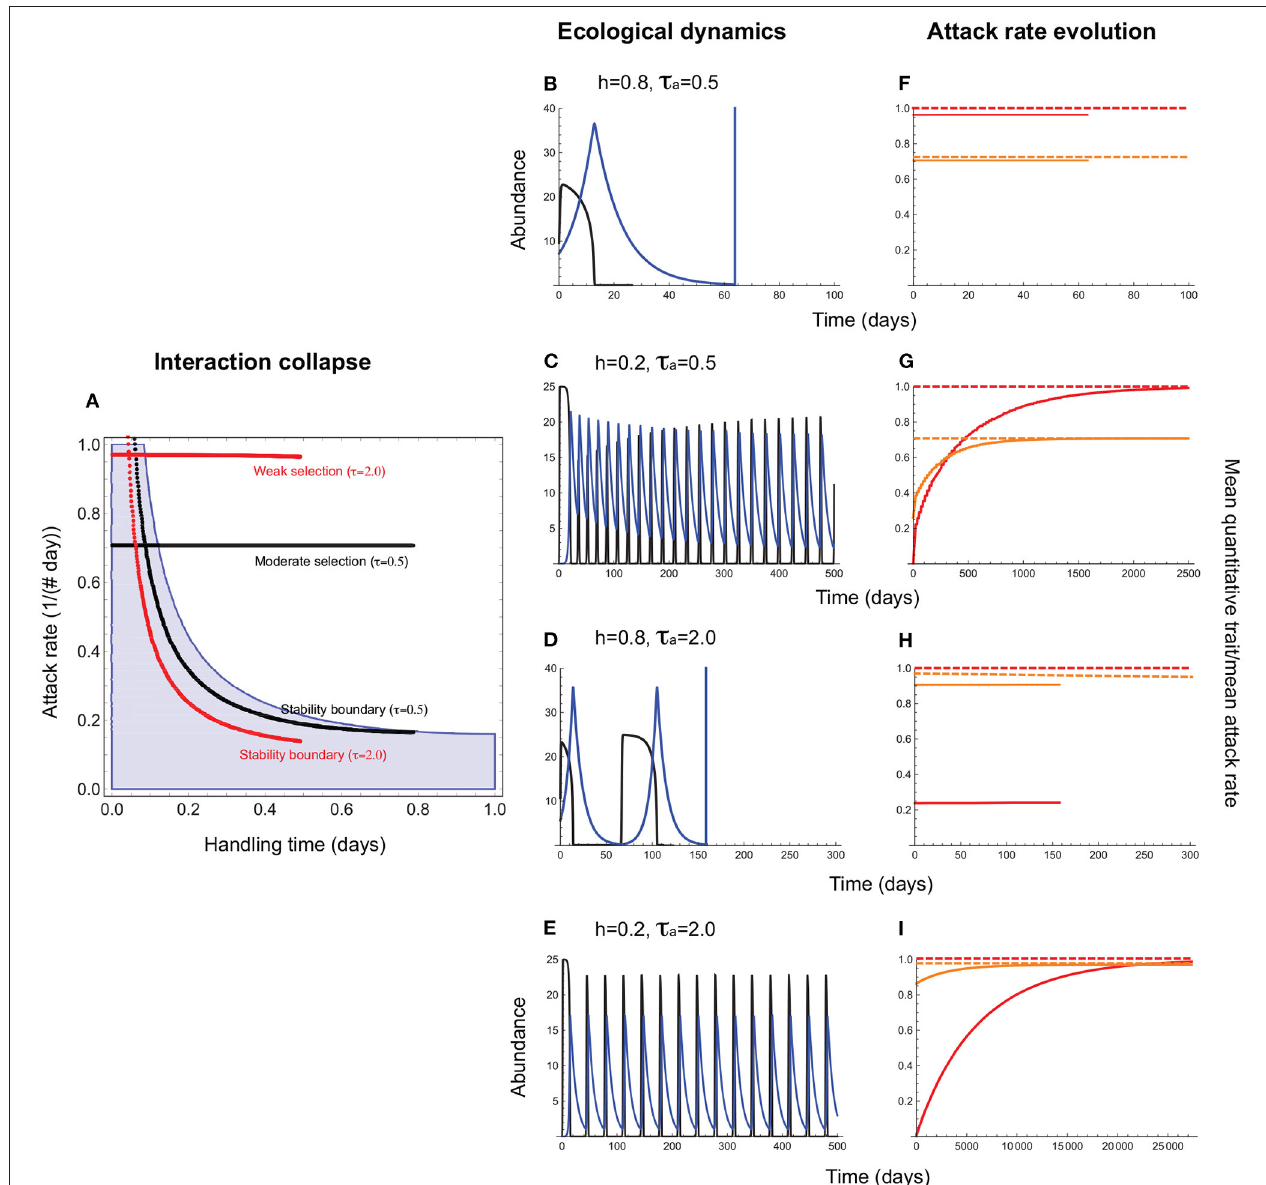
FIGURE 3 | Attack rate evolution (Equation 11) when the handling time acts as a constraint. (A) depicts the attack rate-handling combinations that evolve in the model for varying strengths of stabilizing selection ( τ a ). (B–I) depict four representative cases of eco-evolutionary dynamics. In (A) , the red and black horizontal lines depict the attack rate-handling combinations that evolve in the model for weak ( τ a 2.0) and moderate ( τ a 0.5) selection. Note that these lines terminate before the = = handling time reaches its maximum ( h 1.0) because when h is long, oscillations become sufficiently large to cause interaction collapse if negative feedback is too = weak to prevent divergent oscillations. The red and black curves represent the corresponding stability boundaries calculated using these evolved combinations. The blue shaded region depicts the attack rate-handling time combinations that yield a stable point equilibrium in the absence of evolution ( Appendix A ). (B–E) depict resource (black) and consumer (blue) abundances and (F–I) , the mean attack rate [ a ( x ), orange line] the corresponding quantitative trait mean ( x , red line), the ατ a a ( θ a ) expected optima for a ( x ) ( 0.8) leads to ; orange dashed line) and x ( θ a ; red dashed line). (B,F) illustrate the case when a long handling time ( h √ σ a 2 = = 2 + τ a collapse under moderate levels of selection ( τ a 0.5). (C,G) show that the interaction persists when the handling time is shorter ( h 0.2), albeit with resource = = b a ( θ a )). (D–I) illustrate collapse (long handling time, h abundances reaching extremely low levels, with x and a ( x ) evolving to their respective optima ( θ a and 0.8) and = a ( θ a ) taking much persistence (short handling time, h 0.2) under weak selection ( τ a 2.0). Note that weaker selection leads to slower rates of evolution, with θ a and = = b longer to reach their respective optima [2,500 time units in (E) vs. 25,000 time units in (I) ]. Other parameter values are: r 5.0, q 0.04, e 0.2, d 0.1, σ a = = = = = b